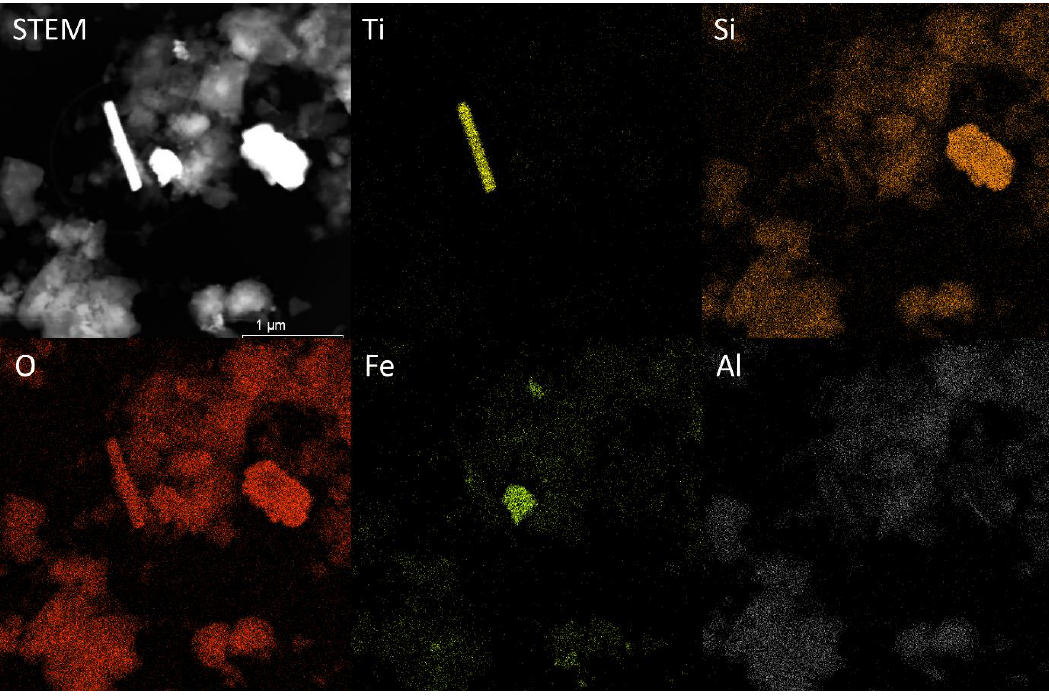
Figure 7. Image obtained using HR-TEM in HAADF scanning mode of soil particles extracted from S2, and the corresponding EDX-maps. Further HR-TEM images are provided in the supporting information.